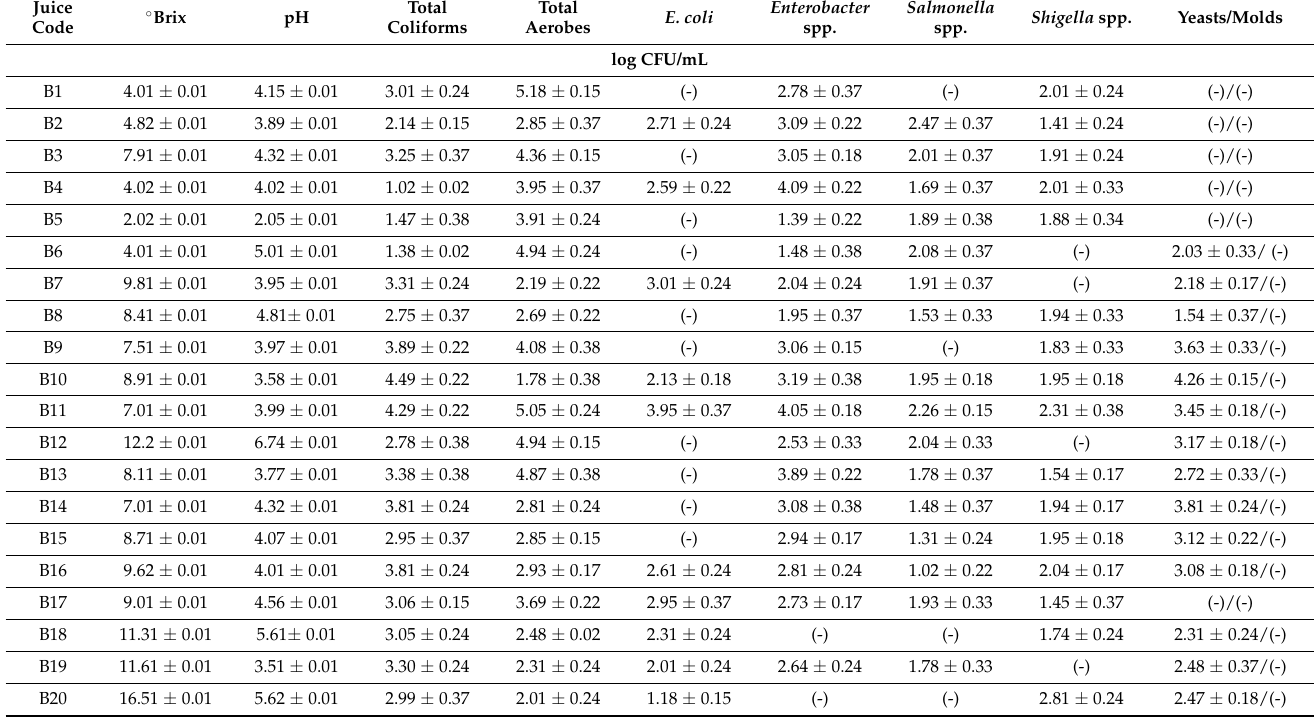
Table 2. Physicochemical characteristics and prevalence of microbial indicators in fresh juices.